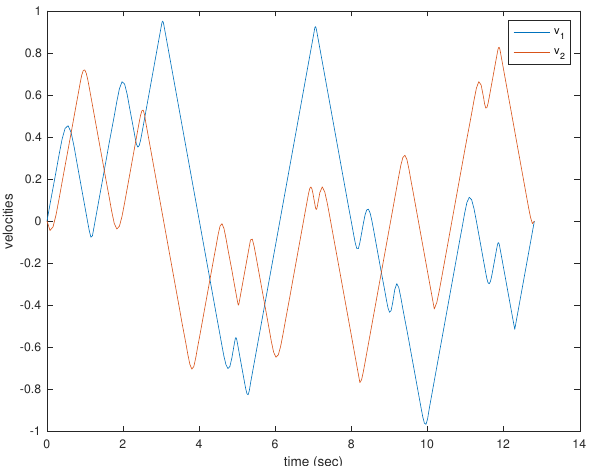
Figure 39. Velocity components of a single agent visiting 30 neighborhoods.